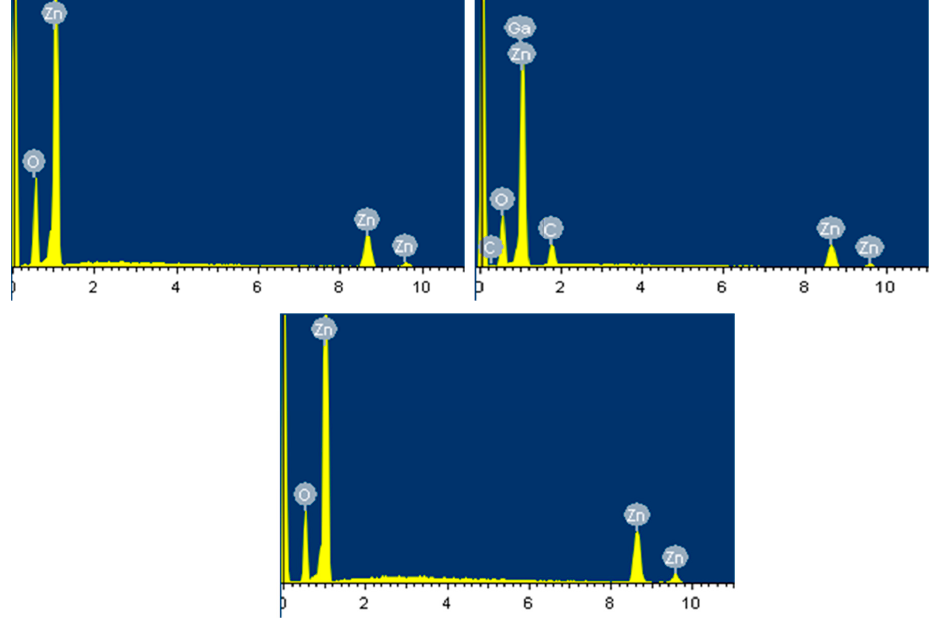
Figure 5 . Energy dispersive X-ray microanalysis (EDXMA) of ( a ) S1; ( b ) S2; and ( c ) S3. Table 2. EDXMA weight and atomic compositions of individual elements in S1, S2, and S3.